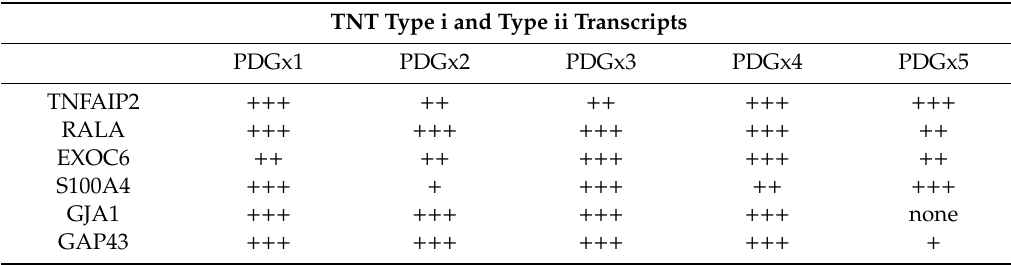
Table 2. Expression of the tunneling nanotube-related transcripts in PDGx neurospheres of di ff